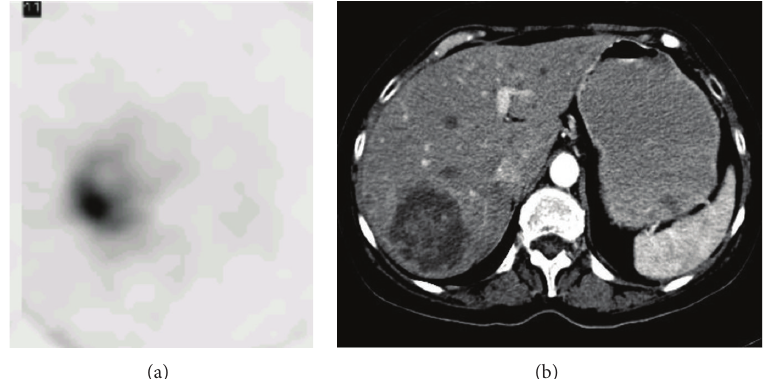
Figure 4: (a) Enlarged necrotic tissue secondary to previous chemoembolization (nonradioactive lipiodol) and (b) correlated CT slice.